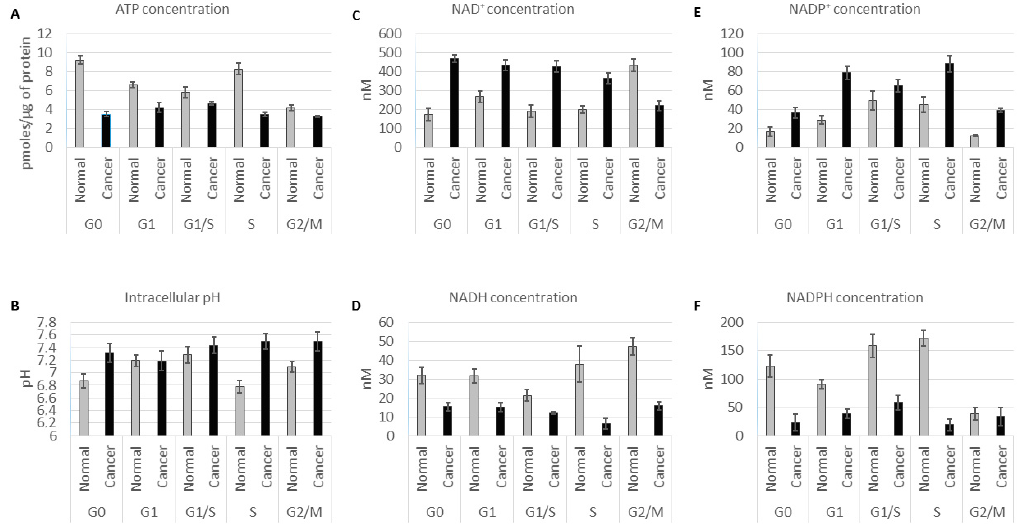
Figure A1. ATP, intracellular pH (pHi) and redox (NAD/NADH, NADP + /NADPH) concentrations and variations throughout colon normal and cancer cell cycle.